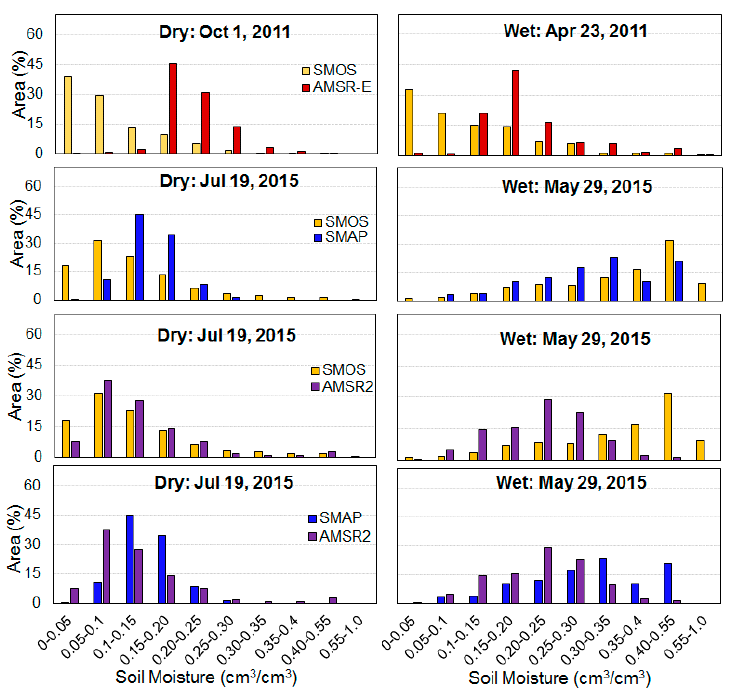
Figure 8. Comparison of soil moisture distributions measured by four different satellites on selected dry and wet days in 2011 and 2015 in the state of Texas.